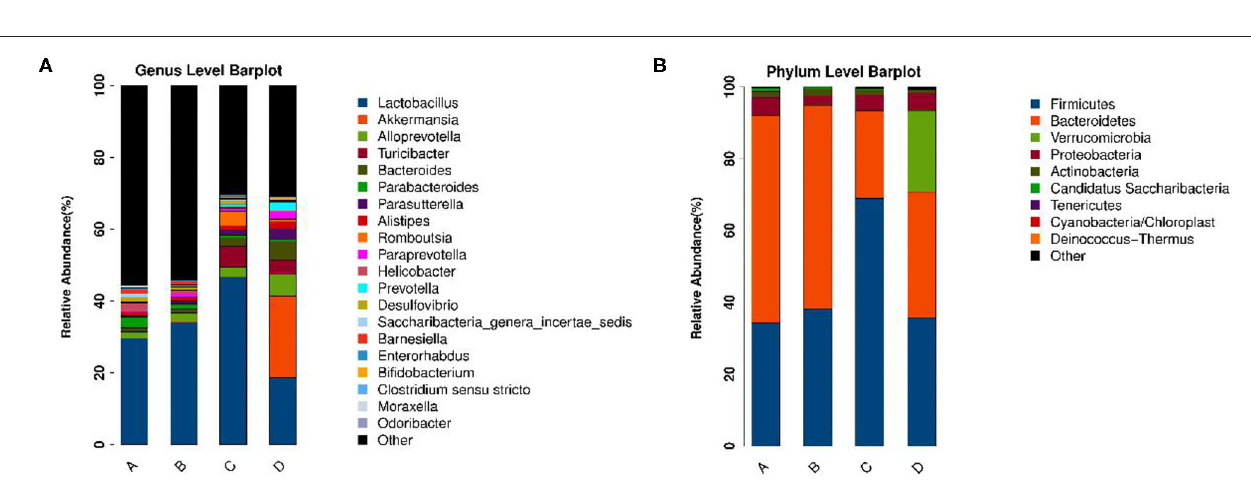
FIGURE 4 | Comparison of β diversity among the control group (group A), the chronic colitis group (group C), and the chronic colitis + Se-enriched L. acidophilus group (group D). (A) The difference in β diversity between the control group (group A) and the chronic colitis group (group C) was statistically significant ( P = 0.032 < 0.05); (B) The difference in β diversity between the chronic colitis group (group C) and the chronic colitis + Se-enriched L. acidophilus group (group D) was statistically significant ( P = 0.019 < 0.05).